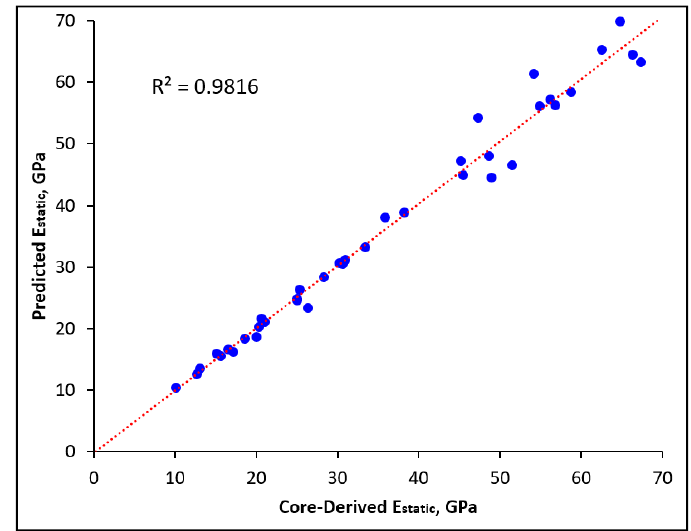
Figure 8. Cross-plot of the core-derived and predicted E static of the validation dataset.